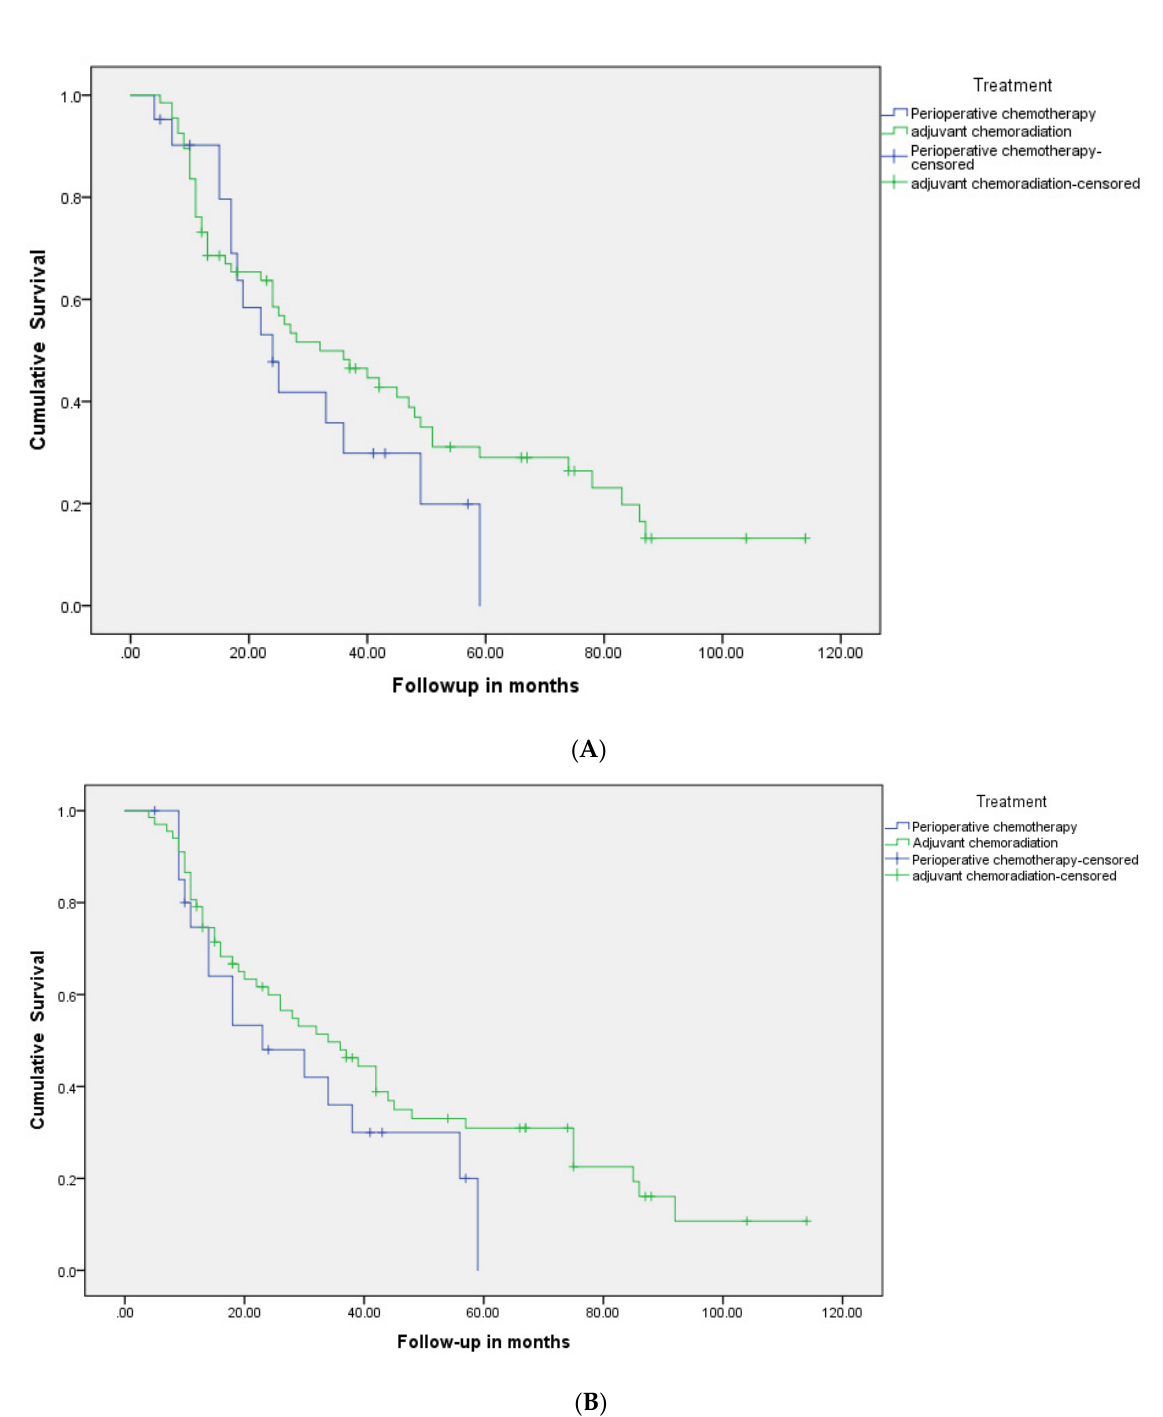
Figure 2. (A): Kaplan-Meier relapse-free survival curves of two groups: patients who were treated with perioperative chemotherapy compared to those who received adjuvant chemoradiotherapy. (B): Kaplan-Meier overall survival curves of two groups: patients who were treated with perioperative chemotherapy compared to those who received adjuvant chemoradiotherapy.